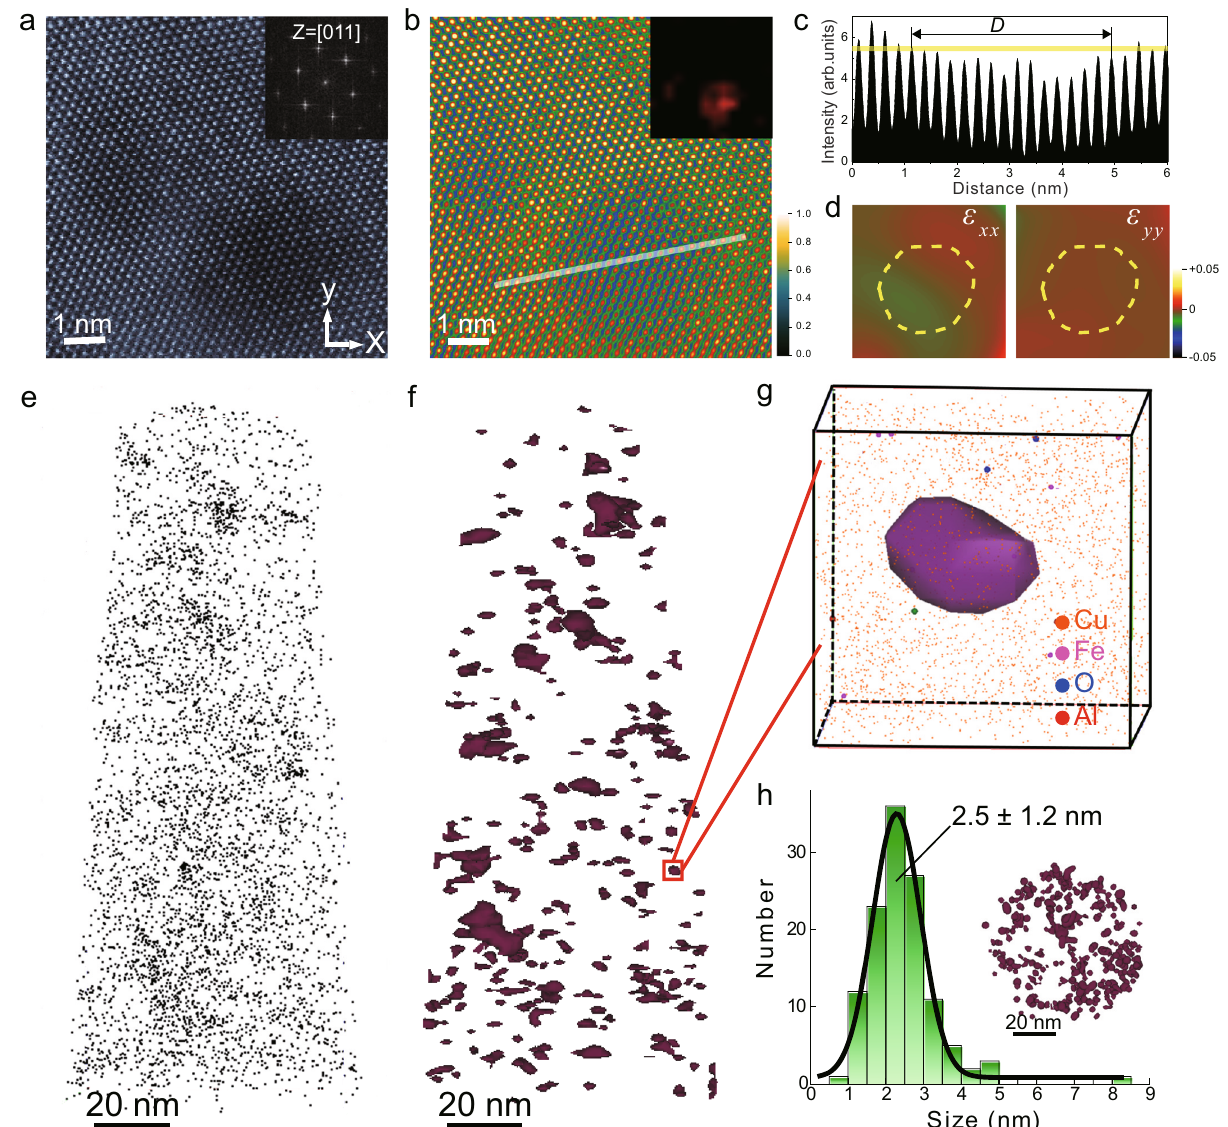
Fig. 2 | High-resolution TEM and APT characterization of nc-Cu composite (0.8vol.%C).a Ahigh-resolutionHAADF-STEMimageofthelocalatomicstructure near unc particles taken along the [011] zone axis, as con fi rmed by the fast Fourier transformation (FFT) pattern in the inset. b FFT- fi ltered image of a . Variation of colour from black to yellow indicates intensities from low to high. Inset is the C imaging map for this region, showing that the low-intensity regions correspond to unc(duetothesensitivityofSTEMimagetoatomicnumberZ).Insetshowstwounc particles determined from their FFT image (see c for clarity). c Intensity pro fi le along the line in b , where the decrease of atom intensity in the unc-contained region is observed. The yellow line, which represents 90% of the averaged atom intensity of the Cu matrix, is taken as the cutoff intensity to estimate the diameter